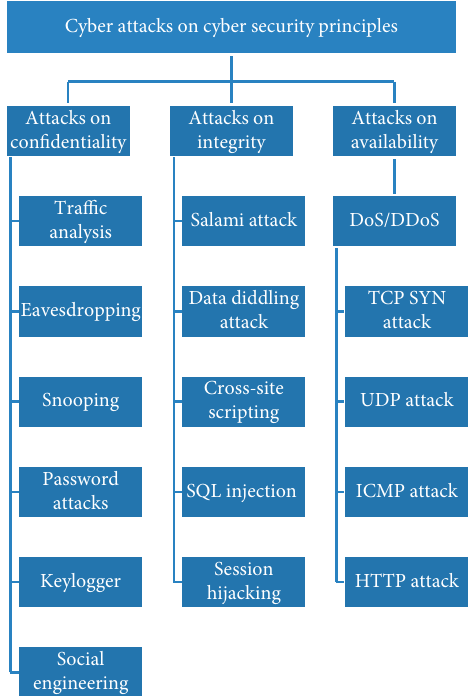
Figure 3: Classification of cyberattacks on the basis of fundamental principles of